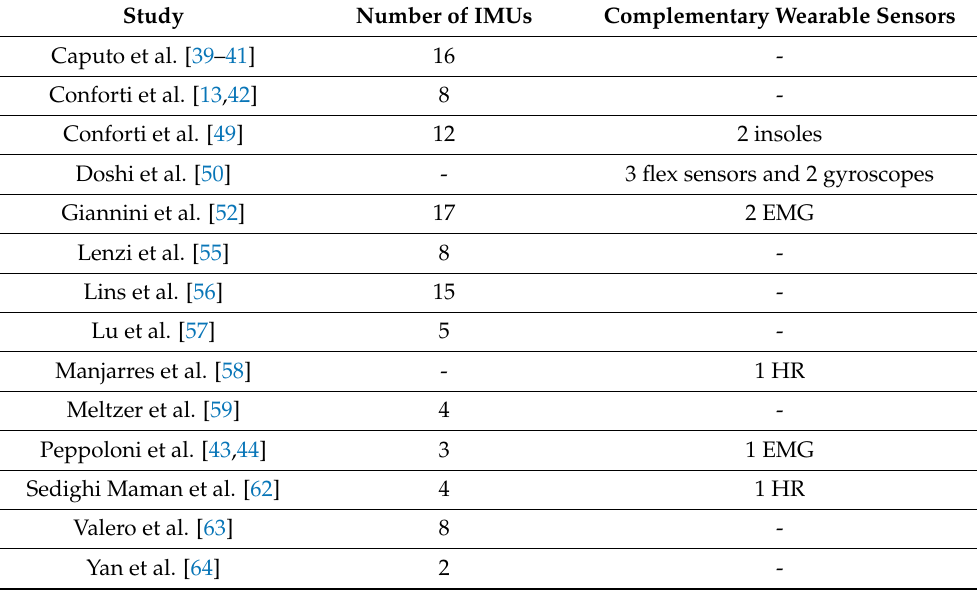
Table 4. Number of IMUs and complementary wearable sensors of the available sensor systems.